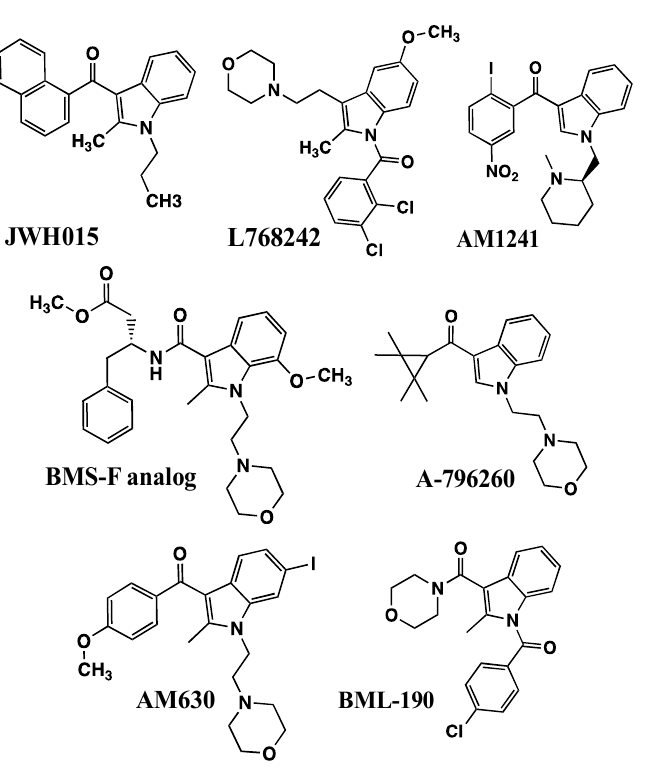
Figure 5. CB 2 -selective indole ligands.